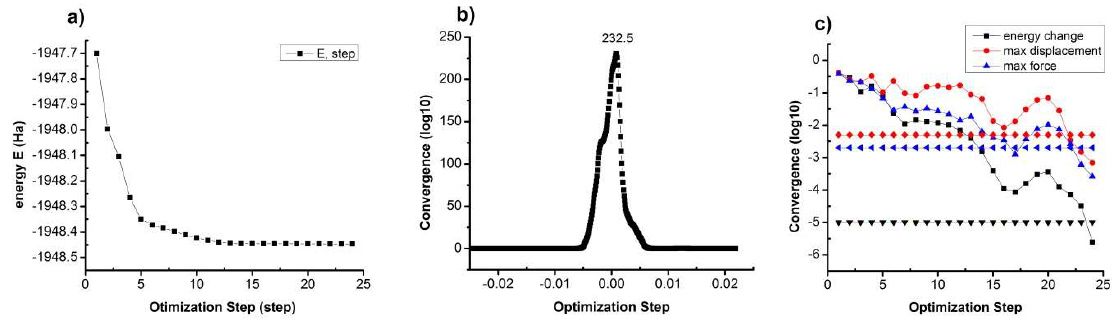
Figure 1. System energy ( a ), electronic density ( b ), electronic state ( c ) of poly(C 13 H 8 OS–H) with a different number of steps.